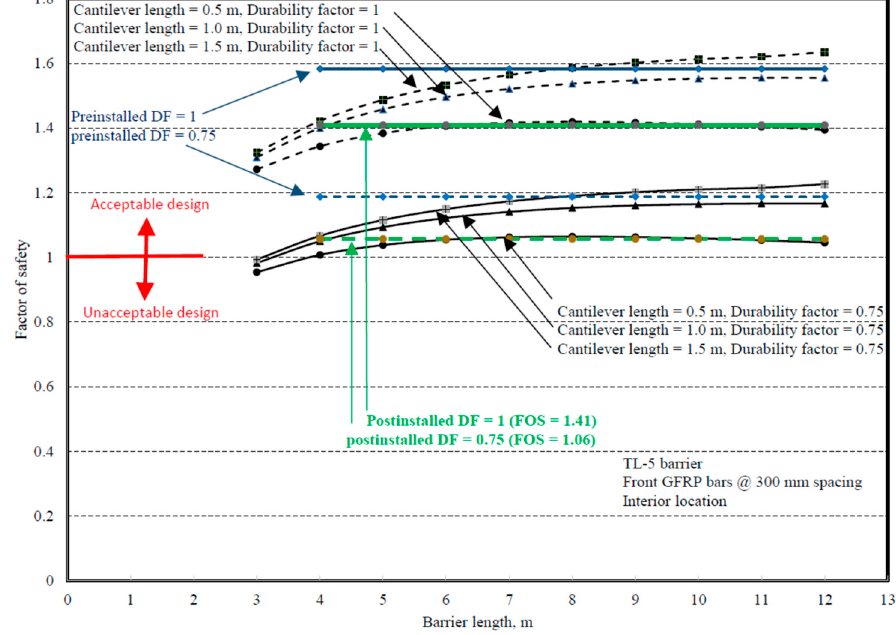
Figure 31. Design factors of safety for TL-5 barrier in Figure 1b at an interior location.